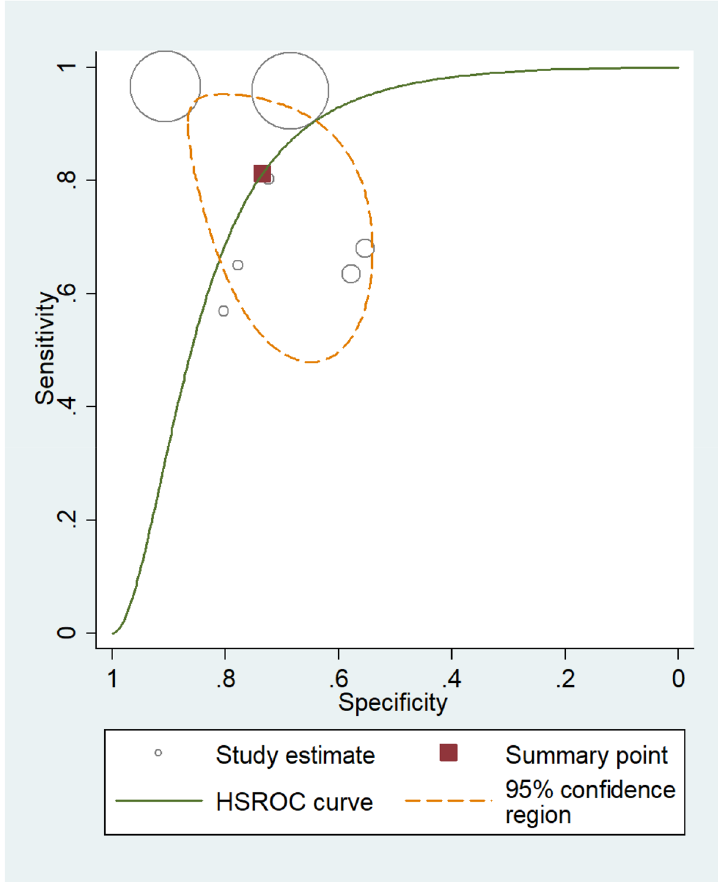
Figure 3. The size of circles indicates the number of patients in a single study. The dark red square shows the sensitivity and specificity summary. The dashed line indicates the 95% confidence region. A meta-analysis of all seven studies revealed that the summary of sensitivity was 81.3% [95% CI 64.0–91.4%] and the specificity was 73.4% [95% CI 62.8–81.9%]. The diagnostic odds ratio was 12.0 [95% CI 3.58–39.9]. According to the AUC 0.82 [95% CI: 0.79–0.86] value, the test was classified as good. HSROC, hierarchical summary receiver-operating characteristic; AUC, area under the